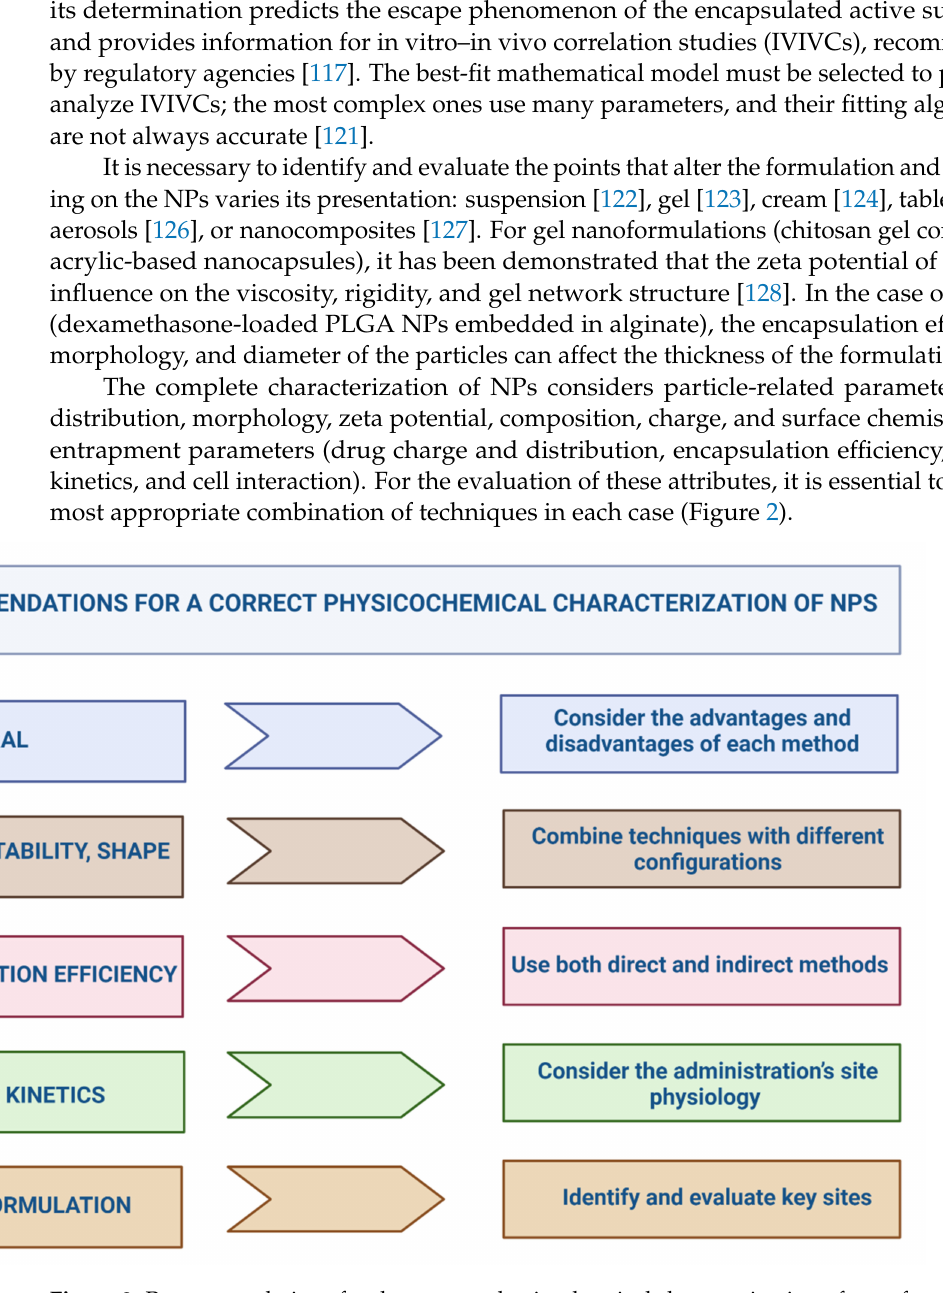
Figure 2. Recommendations for the correct physicochemical characterization of nanoformulations. Particle Size Distribution (PSD). Created with BioRender.com (accessed on 10 December